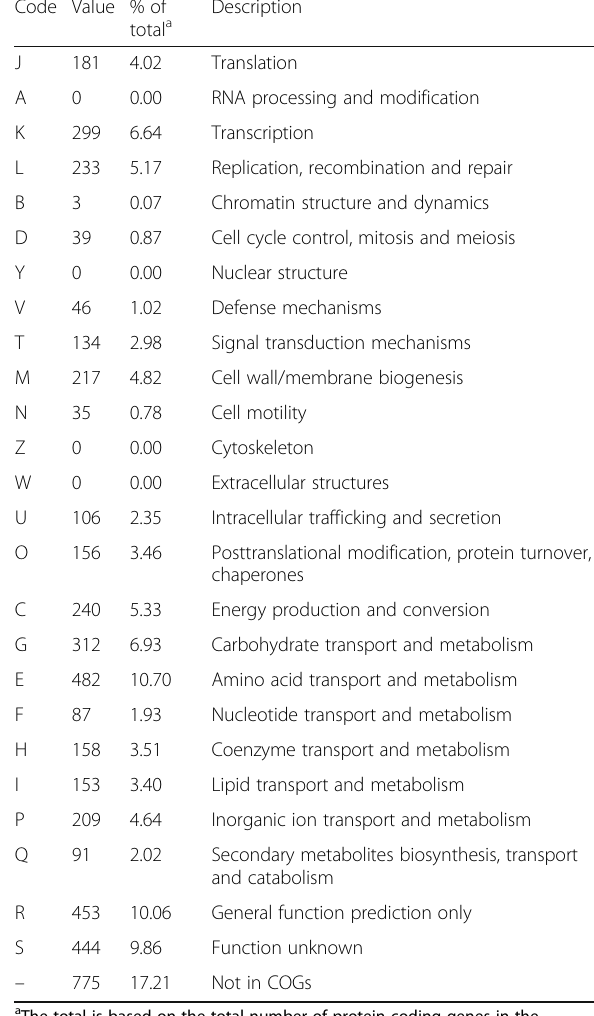
Table 4 Number of genes associated with the 25 general